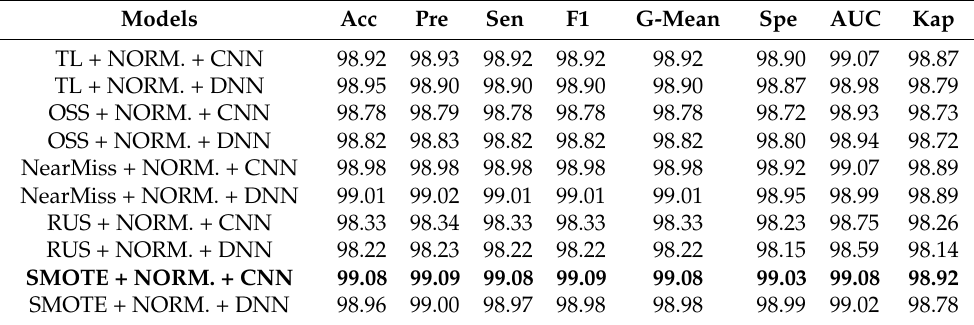
Table 12. The average performance score of the evaluation metrics of the executed models. Models Acc Pre Sen F1 G-Mean Spe AUC Kap TL + NORM. + CNN